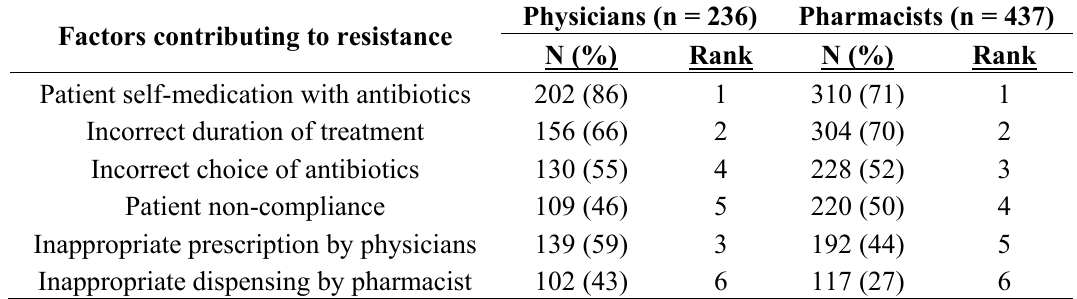
Table 3. Survey responses of physicians and pharmacists regarding factors that contribute to antibiotic resistance.